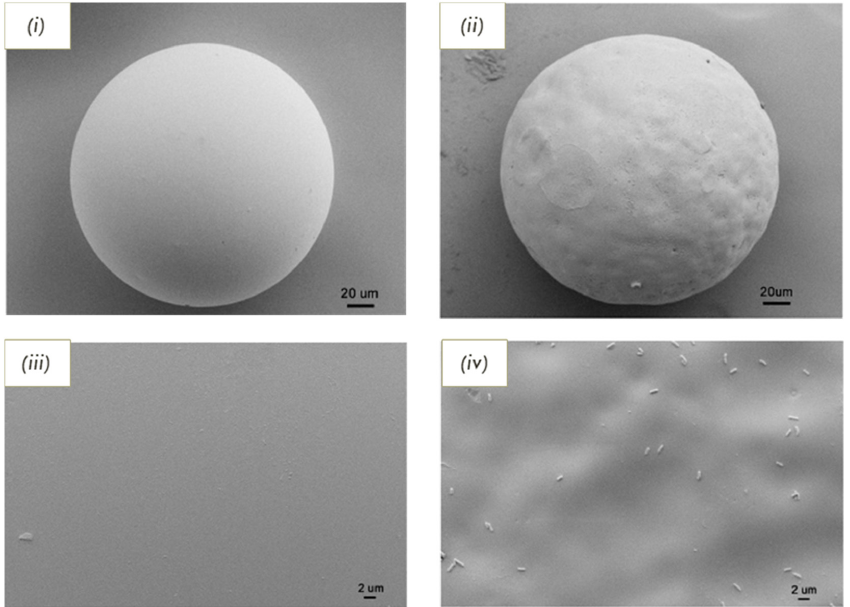
Figure 4. Scanning electron microcopy (SEM) images of ( i ) non-Imprinted particle and ( ii ) imprinted particle; and corresponding magnified images of ( iii ) non-imprinted and ( iv ) imprinted beads. Figure adapted from [197] with permission under open-access copyright agreement.